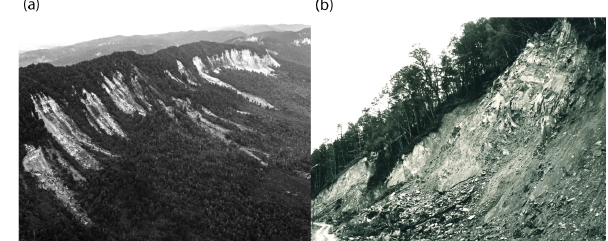
Figure 2. (a) 1968 rock falls from limestone bluffs at White Cliffs Escarpment, 5km west of Inangahua. (b) 1968 rock and debris fall area in the upper Buller Gorge.